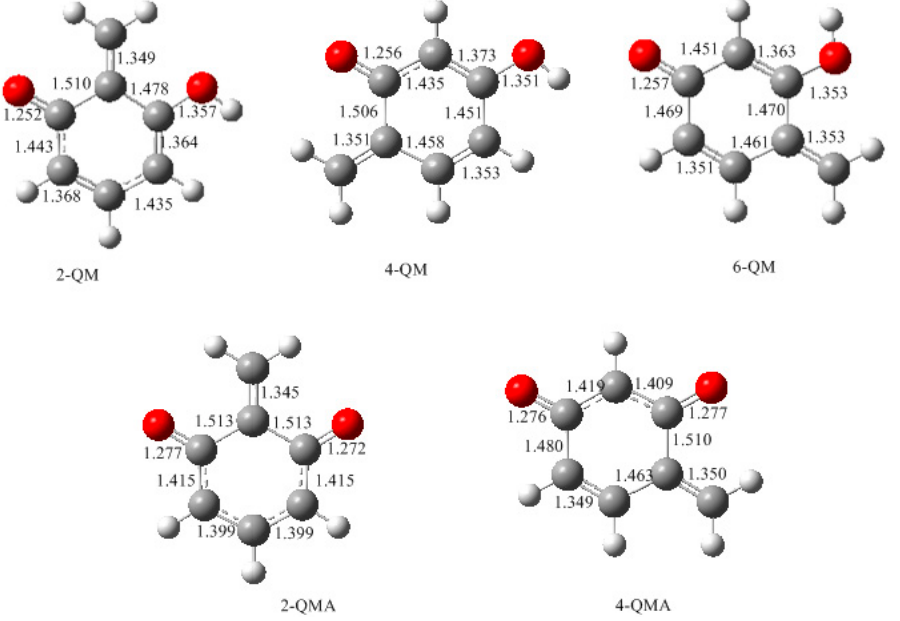
Figure 4. The calculated structures for the neutral quinonemethides (QM) and quinonemethide anions (QMA).